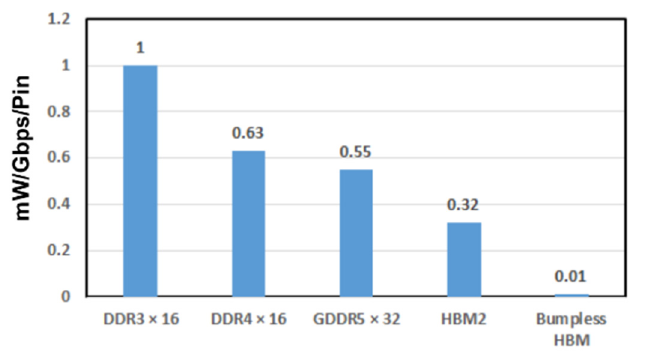
Figure 37. Data bandwidth roadmap [82–87].